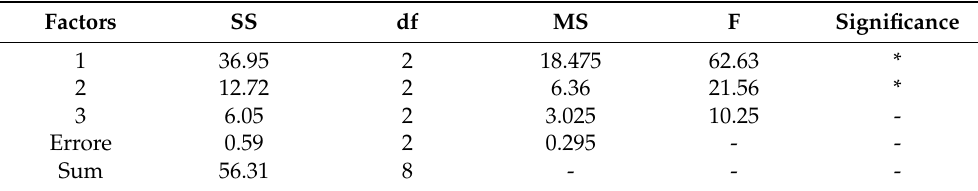
Table 4. Variance